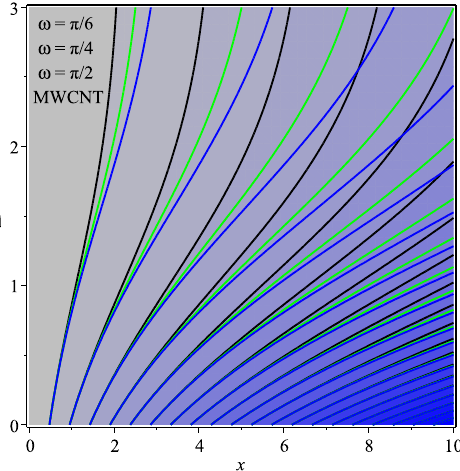
Figure 19. Repercussion of ω with φ = 0.1, M egt = 0.5, Ω = 1, κ = 2.5 on stream lines.